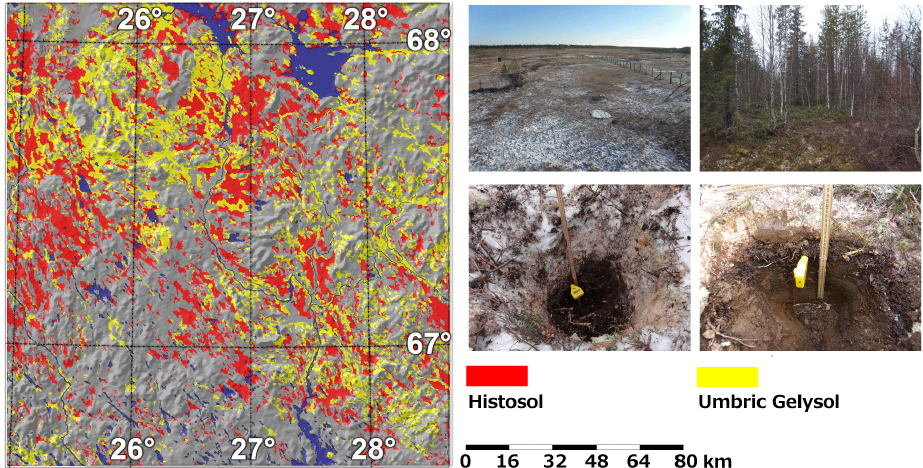
Figure 4. Distribution of organic (Histosols) and semi-organic (Umbric Gleysols) soils within the Sodankylä region (left panel) and typical top soil profiles and vegetation (right